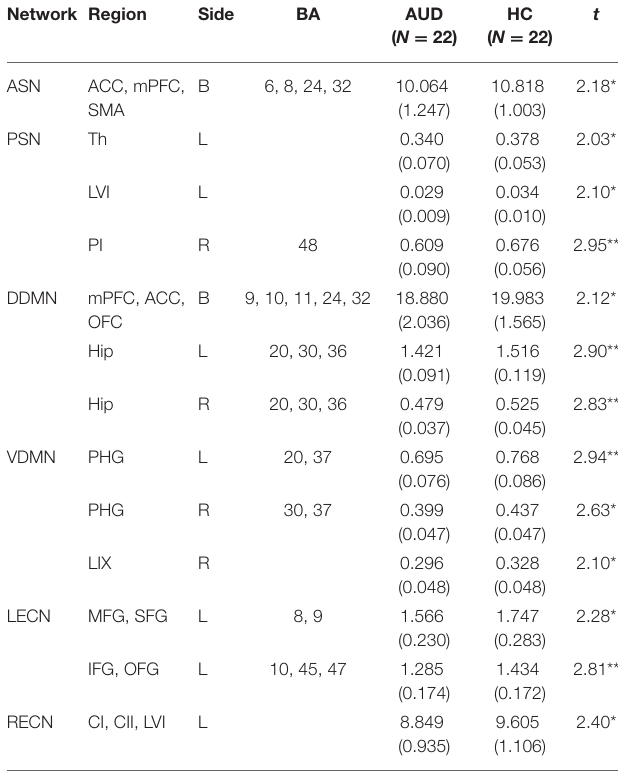
frontal gyrus and superior frontal gyrus ( Table 4 ; Figure 4